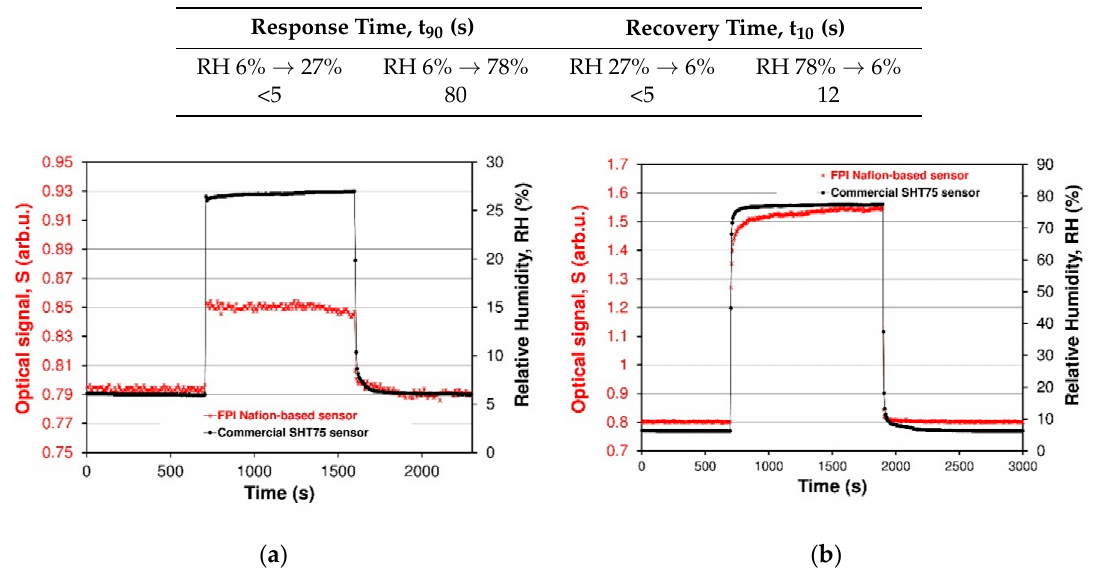
Figure 15. Calculation of response and recovery times from dynamic response graphs in Figure 12. The curves are relative to a RH of ( a ) 27% and ( b ) 78%, respectively.